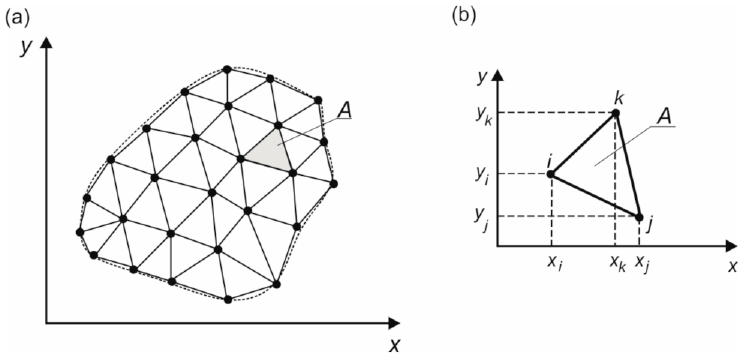
Figure 1. Spatial discretization: ( a ) domain covered by M triangular elements e with area A ; ( b ) trian- gular element with three computational nodes i , j , and k